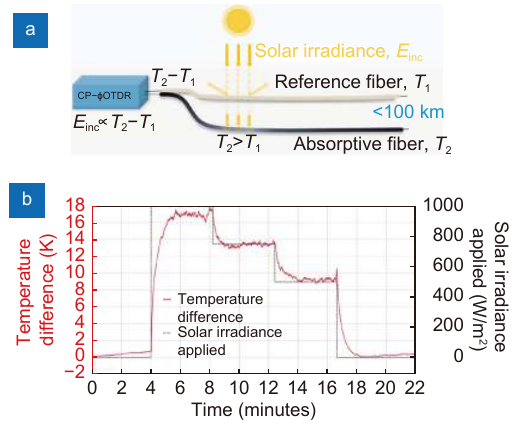
Fig. 17 | ( a ) Operation principle of the Φ-OTDR based solar irradi- ance sensing system. ( b ) Temperature difference between the black and reference fiber vs. the applied solar irradiance. Figure repro- duced from ref. 183 , under a Creative Commons Attribution 4.0 Inter- national